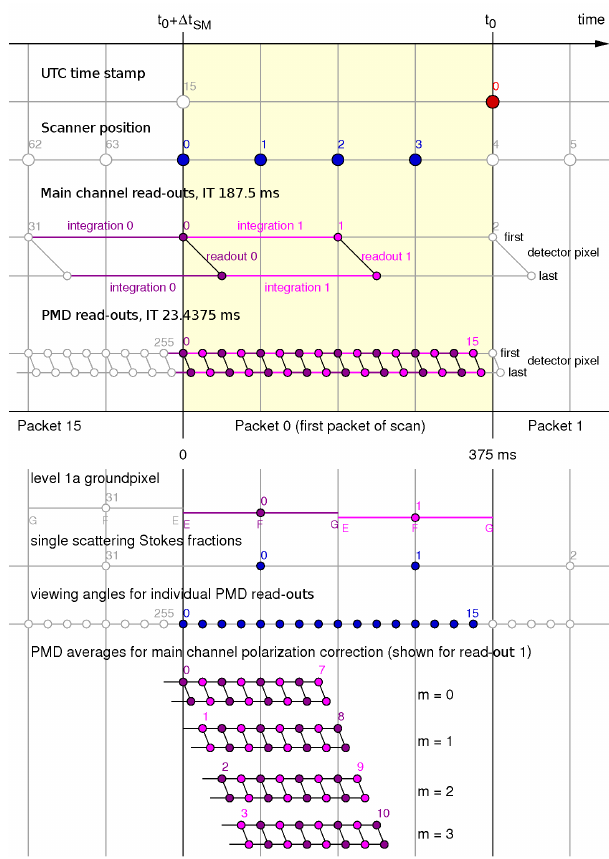
Figure 6. Synchronization diagram. Synchronization of time stamp, scanner positions, and detector read-outs within a GOME-2 science data packet, and selected quantities of the level 0 to 1a processing. The data transmitted in packet 0 (the first of a scan) are indicated by the filled circles. Open circles belong to the previous or next data packet. For this figure, (cid:49)t SM was assumed to be − 375ms. The indexing refers to a complete